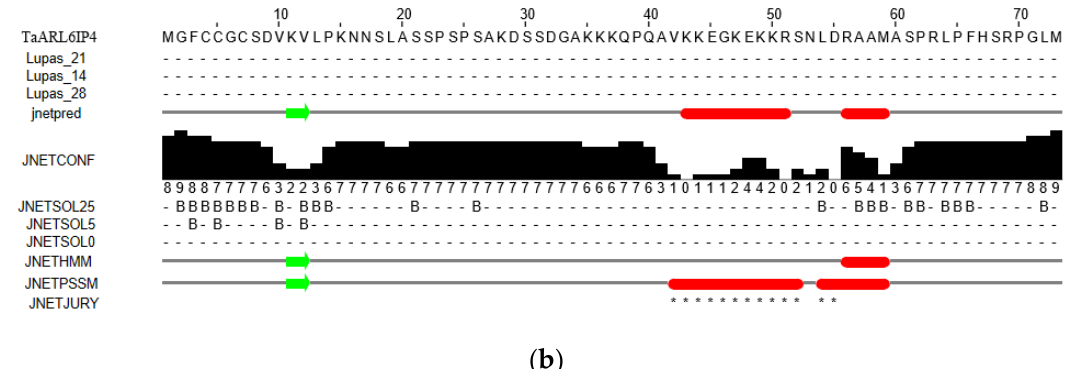
Figure 2. ( a ) ClustalW multiple sequence alignment of TaARL6IP4 with synthesized DON-affinity binders (accessions: AEI91798.1, AEI91799.1, and AEI91780.1) and DON binding/catalysis enzyme TRI101 from F. graminearum and F. sporotrichioides indicate a highly conserved HXXXD/G motif (highlighted in the green box) and glycine and proline residues (marked by asterisks). ( b ) Prediction of the secondary structure of TaARL6IP4 by Jpred 4 (helices are marked as red tubes and sheets as green arrows).